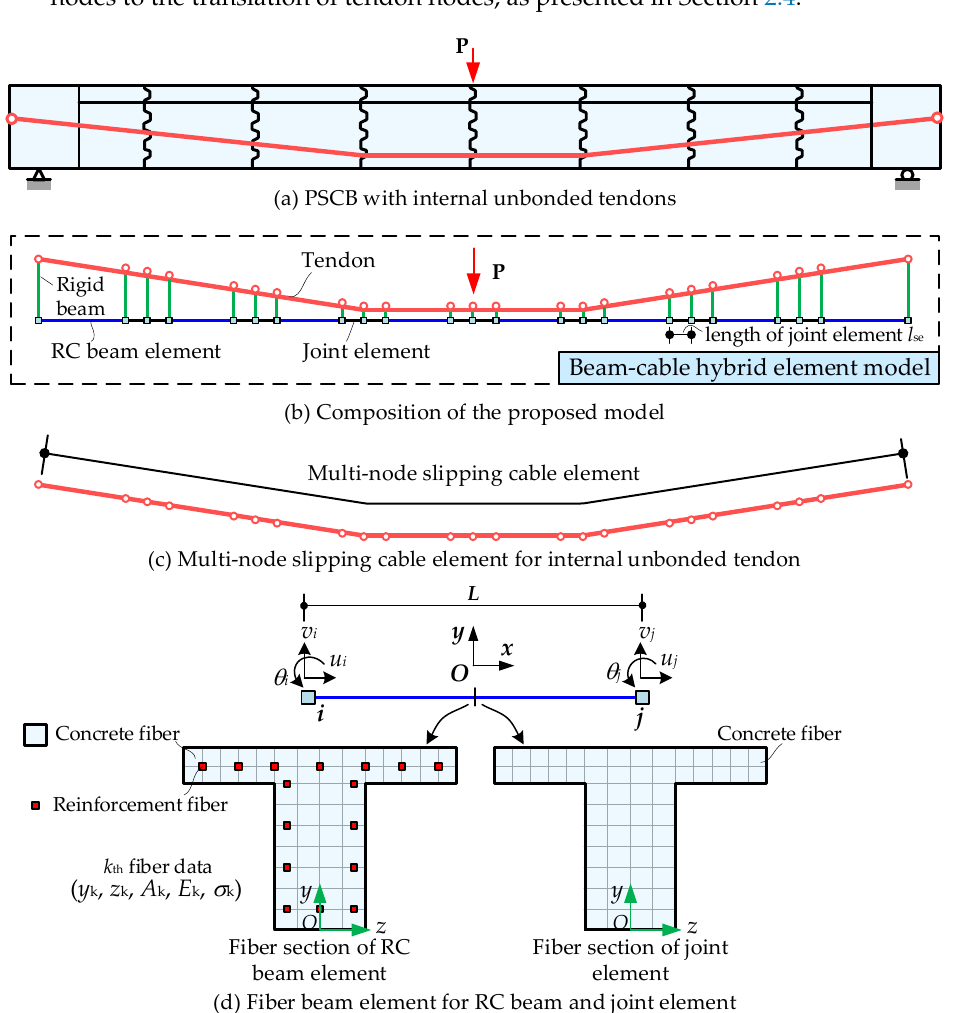
Figure 2. Modeling schemes of the proposed model.